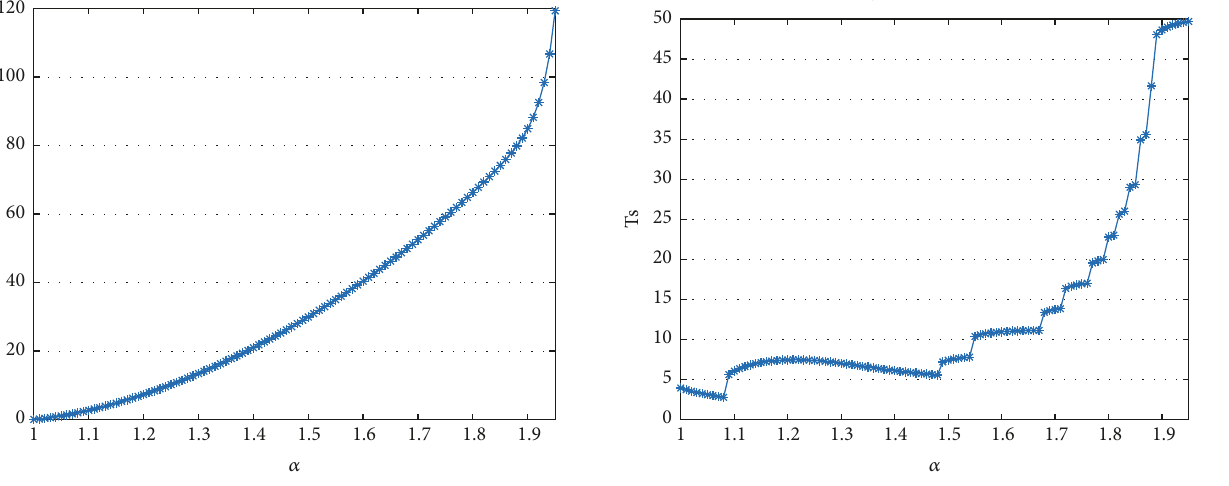
Figure 3: Overshoot percentage with different 𝛼 .